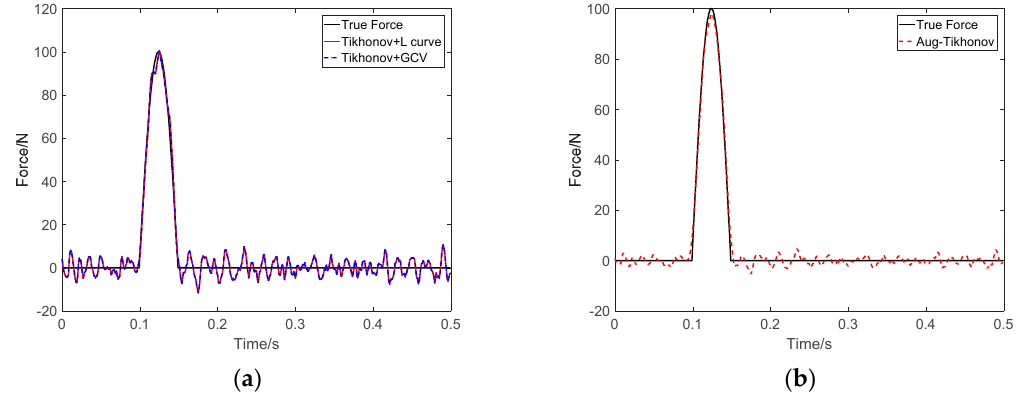
Figure 11. Identification result of impact load at SNR 40 dB: ( a ) Tikhonov method; ( b ) the proposed method.